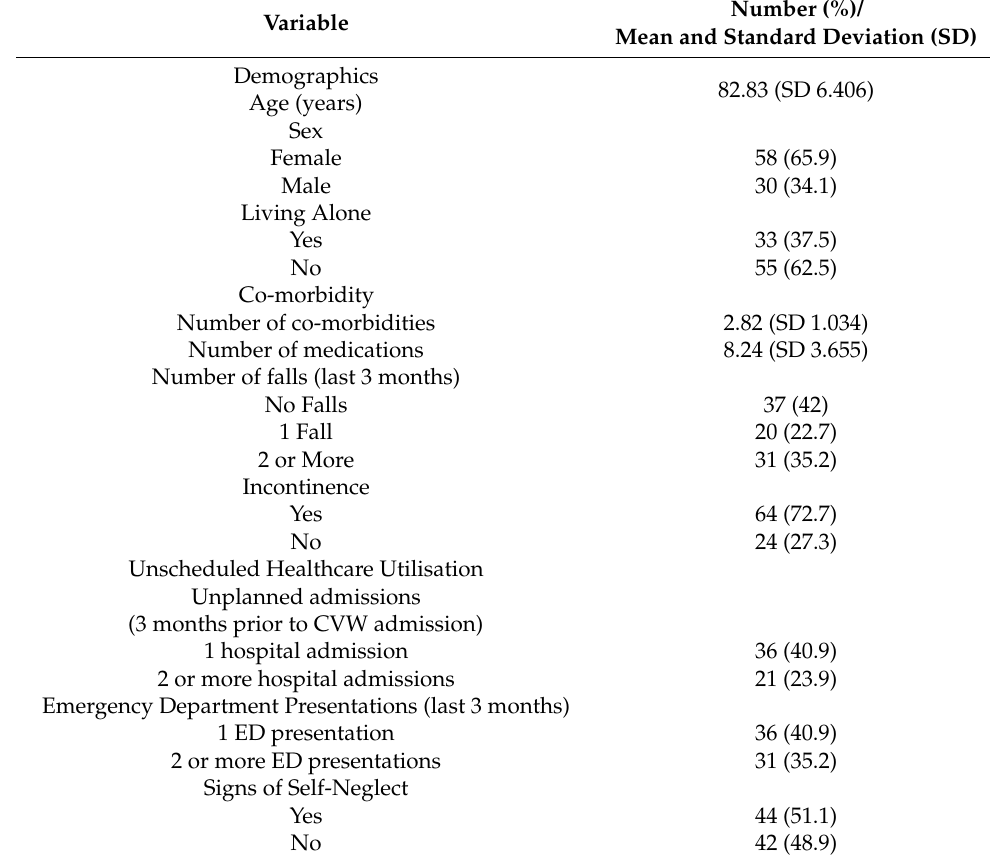
Table 3. Admission characteristics including demographics, co-morbidity and recent healthcare utilisation of patients (n = 88) in the Community Virtual